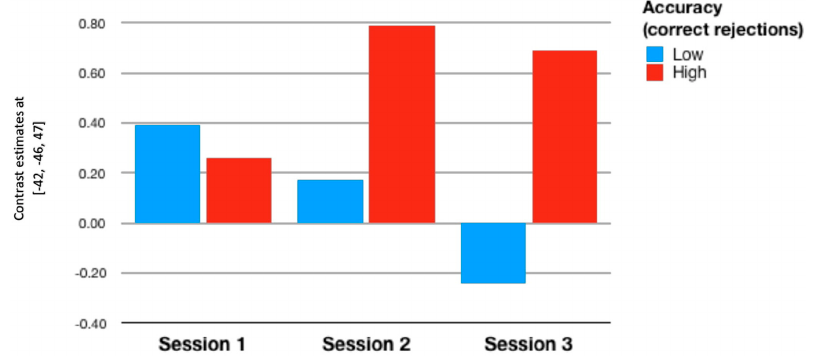
Figure 3. Contrast estimates in superior parietal lobule depending on the scanning session and accuracy in the N-back task. Contrast 1 (‘Hits’). Visualization has been prepared independently of the statistical computations, in which the accuracy variable was kept